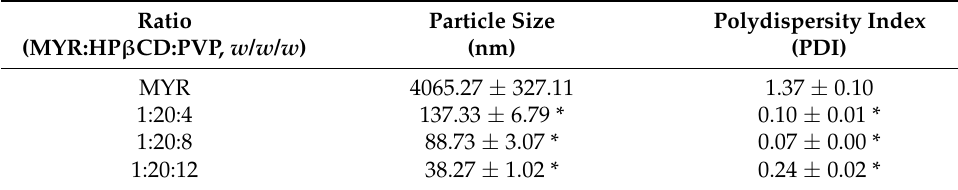
Table 2. Particle size of MYR and its nanofibers detected by laser particle size